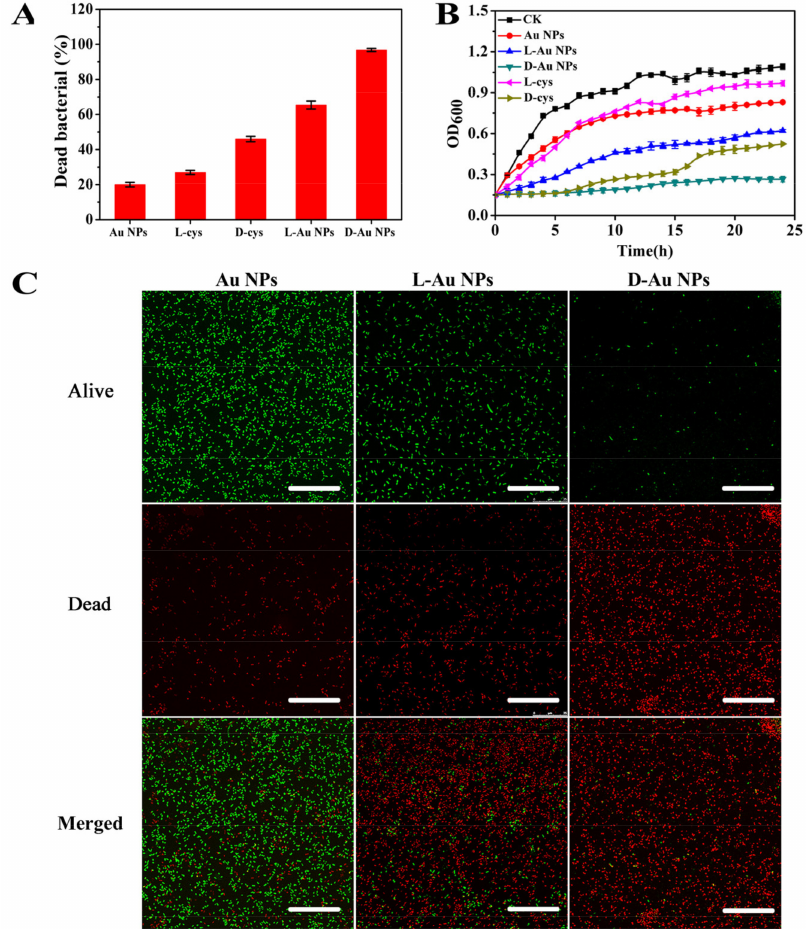
Figure 2. ( A ) Percentage of dead E. coli after treatment with D -/ L -cysteine, Au NPs and D -/ L -Au NPs at 3 mg/mL for 12 h, respectively. Insert: Agar plates showing bacterial colonies after different treatments (Dates are presented as the mean ± s.d.). ( B ) The growth kinetics of E. coli incubated with D -/ L -cysteine, Au NPs and D -/ L -Au NPs for 24 h, respectively. ( C ) Confocal microscopy images of E. coli after treatment with Au NPs, L -Au NPs and D -Au NPs, for 12 h, respectively. The scale bar is 25 µ